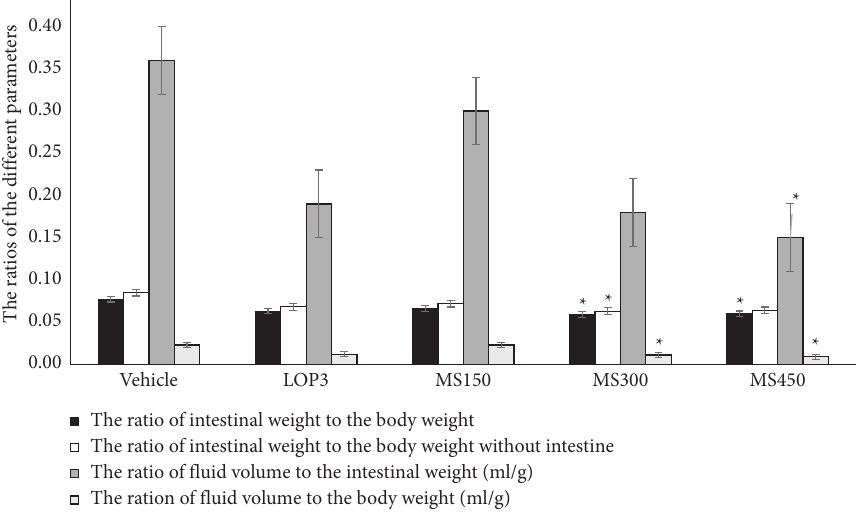
Figure 1: The effect of 80% methanolic leaf extract of M. stenopetala on different ratios as a measure of antisecretory or antienteropooling effect. ∗ p < 0.05 compared to the negative control, Vehicle � 2% tween 80, LOP3 � loperamide 3mg/kg, MS150 � 150mg/kg